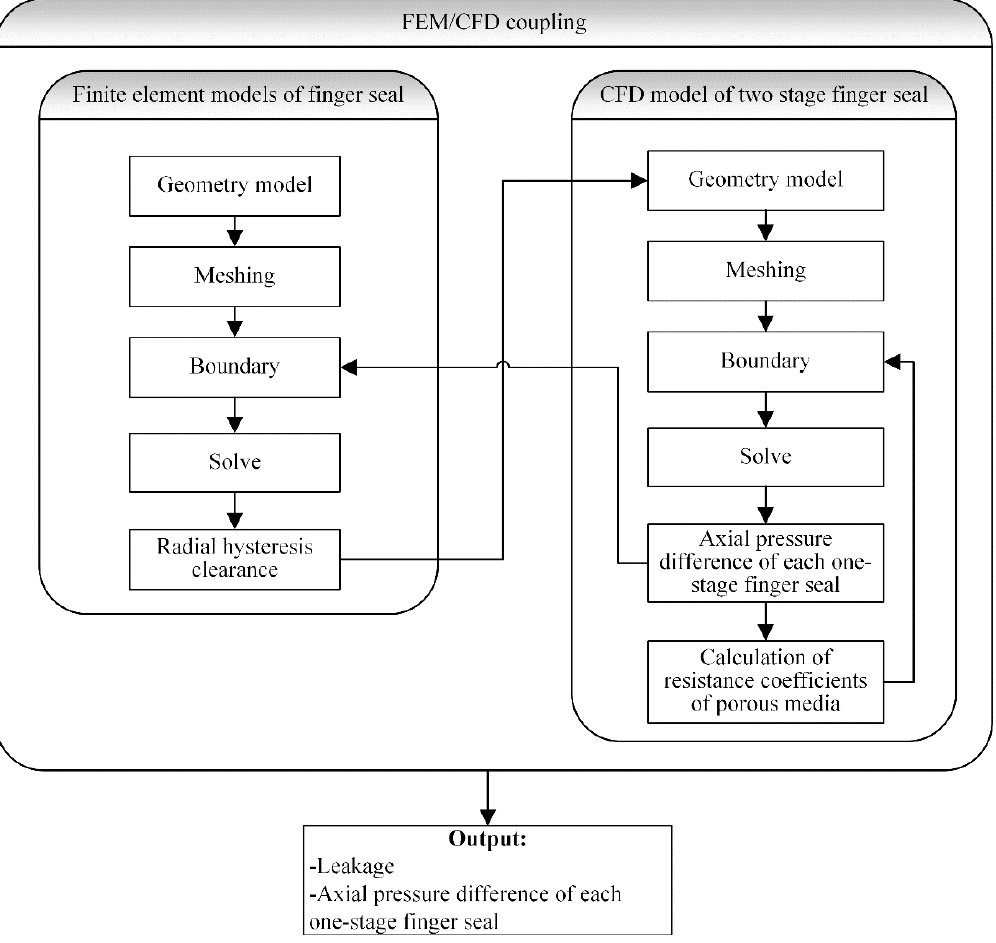
Figure 2. Flowchart of 2SFS performance analysis based on the FEM/CFD coupling iterative algorithm.